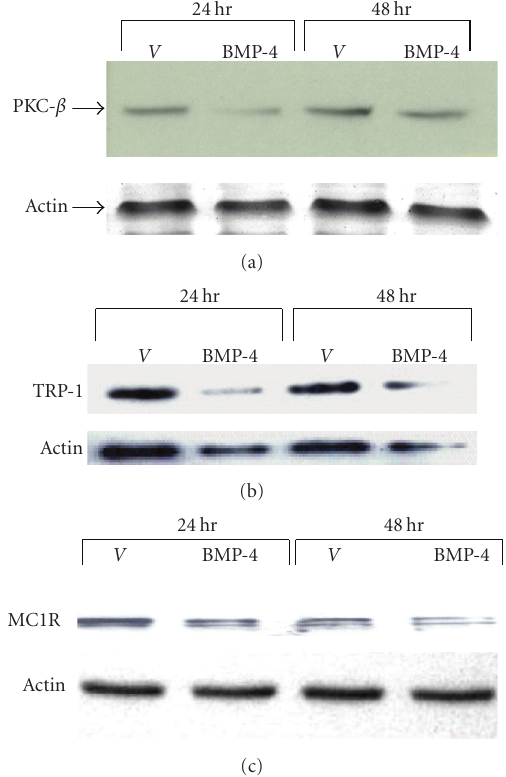
Figure 1: BMP-4 decreases the protein levels of PKC - β , TRP-1, and MC1-R . Paired cultures of melanocytes were treated with either vehicle or BMP-4 (25ng/mL). Cells were then harvested at 24 and 48 hours for immunoblot analysis using monoclonal antibodies specific for PKC- β (a), TRP-1 (b), and MC1-R (c). The protein level of actin was used for the loading control. The level of PKC- β protein was decreased by 49.9 ± 29.7% ( P < . 04) at 24 hours and at 48 hours by 47.7 ± 18% ( P < . 04) [23, 27]. The levels of TRP-1 was decreased by 45% ± 5.0% ( P < . 05) and 36 ± 6.5.0% ( P < . 045) at 24 and 48 hours time points, respectively (Figure 1(b)). The protein level of MC1-R was decreased by 50% ± 2.0% ( P < . 03) and 55% ± 2.5% ( P < . 05) at 24 and 48 hours, respectively (Figure 1(c)). A representative result from five separate experiments is shown.